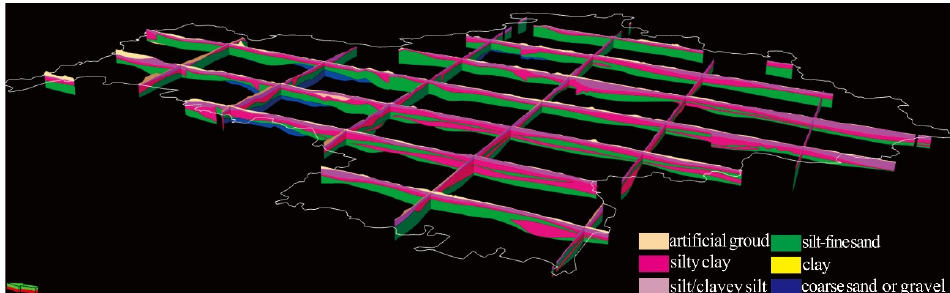
Figure 8. Schematic diagram showing the first cyclothem in the study area.